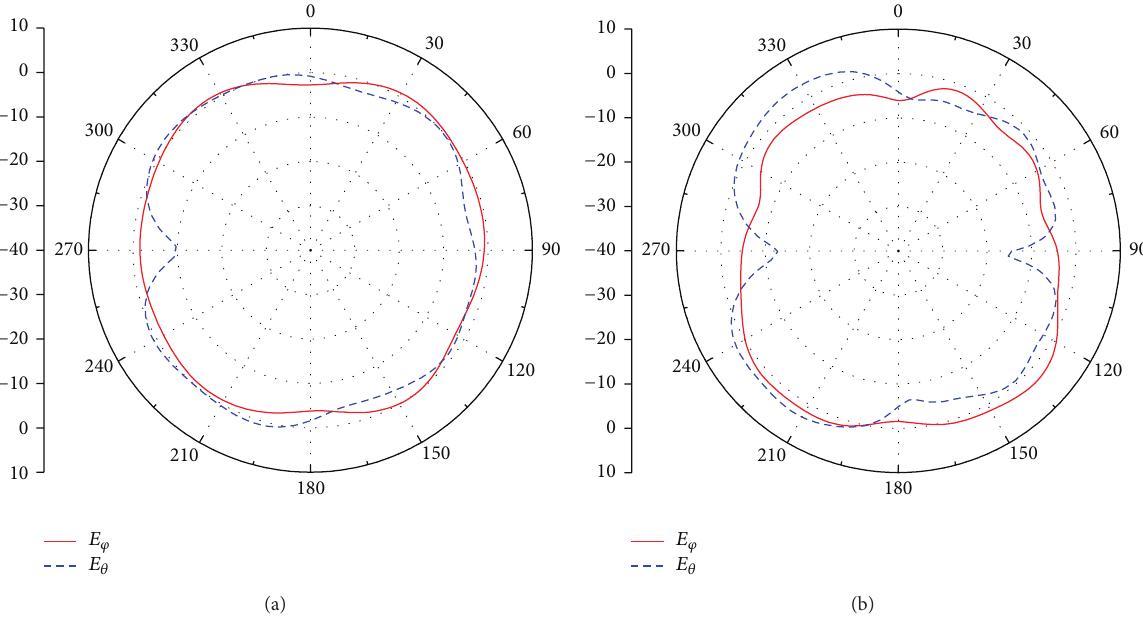
Figure 9: Simulated radiation patterns of the UWB antenna integrated with EBGs in 𝑥𝑧 -plane at (a) 4 GHz and (b) 9 GHz.